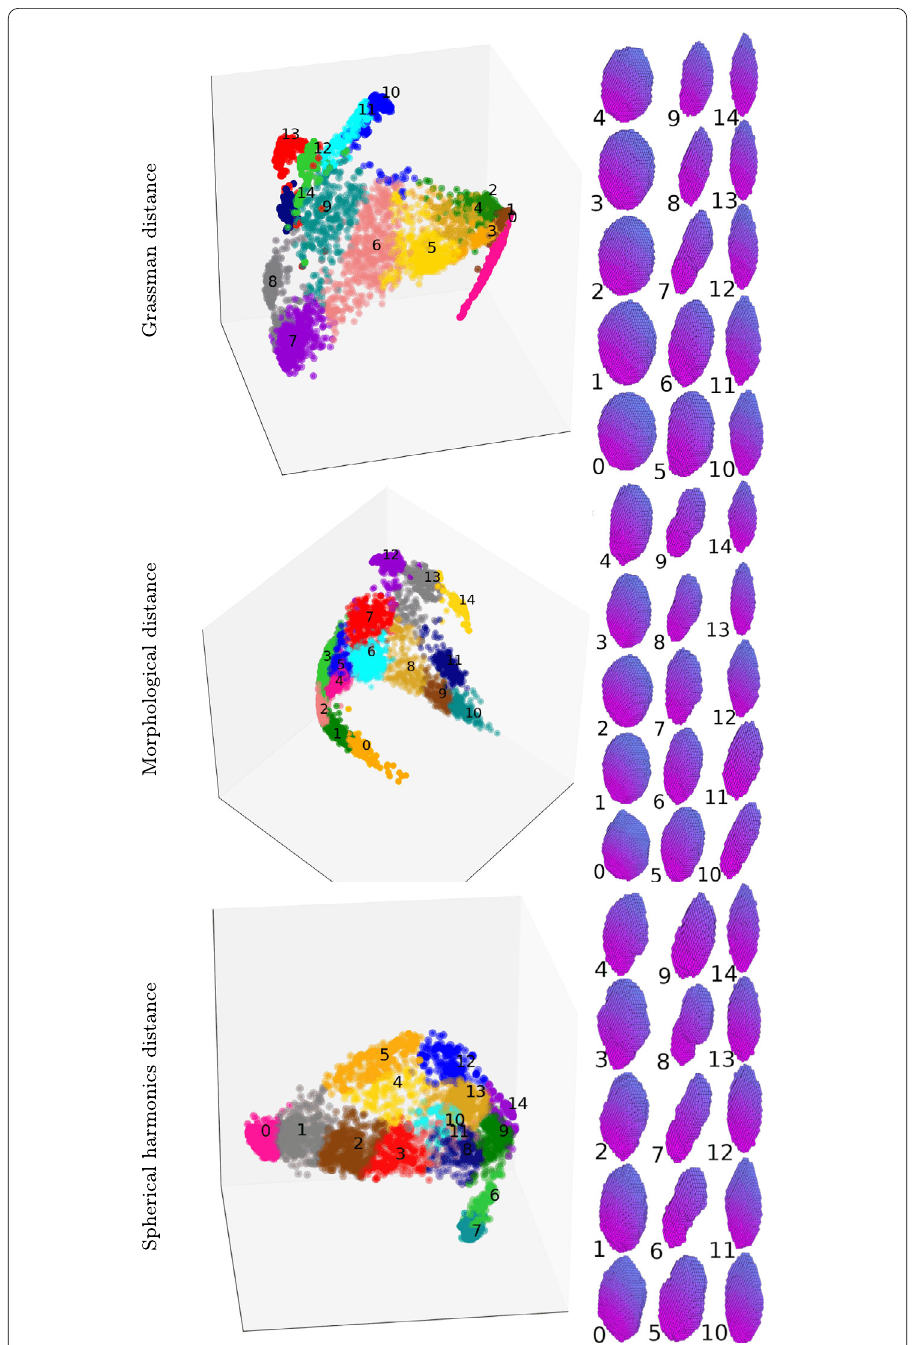
Figure 15 Clustering provided by the k -medoids algorithm using the Grassmann, morphological and spherical harmonics distances, after data augmentation. Medoids on right